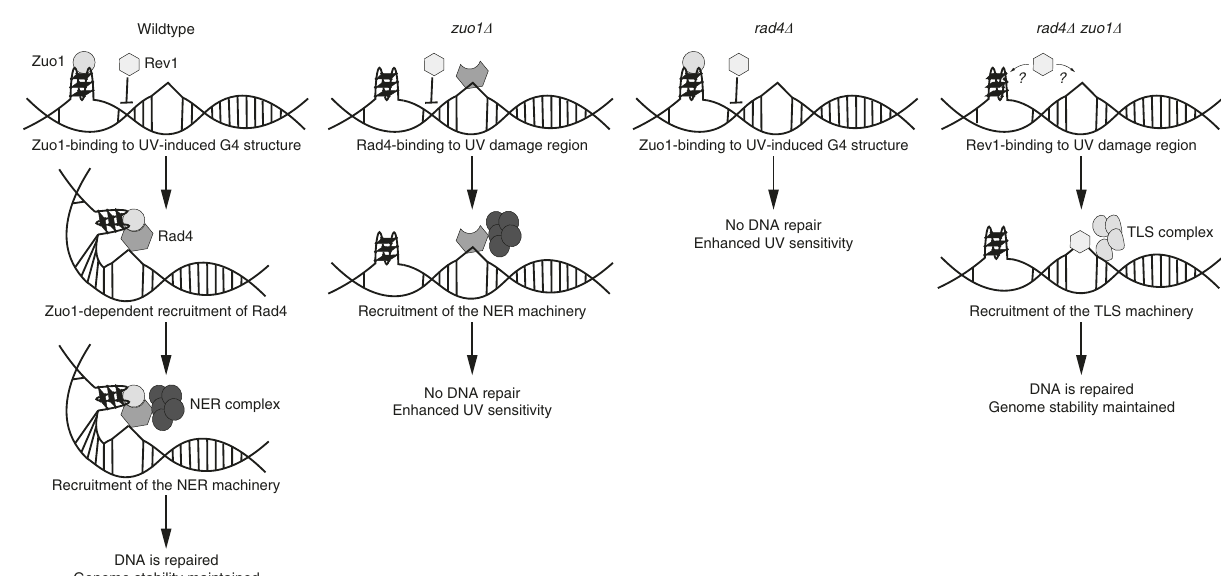
Fig. 6 Illustration of Zuo1 function in G4 structure recognition, stabilization of DNA damage sites and the recruitment of the NER machinery. In detail, UV exposure induces thymine dimer formation in the double helix. As a consequence, more G4 structures are formed that are supported by Zuo1 in the vicinity of the lesion. This stabilization stimulates the binding of the Rad4/23 complex. In the meantime, Zuo1 blocks the binding of Rev1 to those sites. The Rad4/23 complex recruits the NER machinery to repair the lesion and restore the double helix. Without Zuo1, G4 structures are not protected and cells are UV sensitive and the NER machinery is not recruited to the UV lesion. Only in the absence of both Zuo1 and a functional NER machinery an alternative pathway (TLS) is free to bind to these sites and repair the W303 (R. Rothstein) or YPH background 77 . Deletions eliminated entire ORFs and were created using the pRS vector system 77 . Tagging at the endogenous locus with